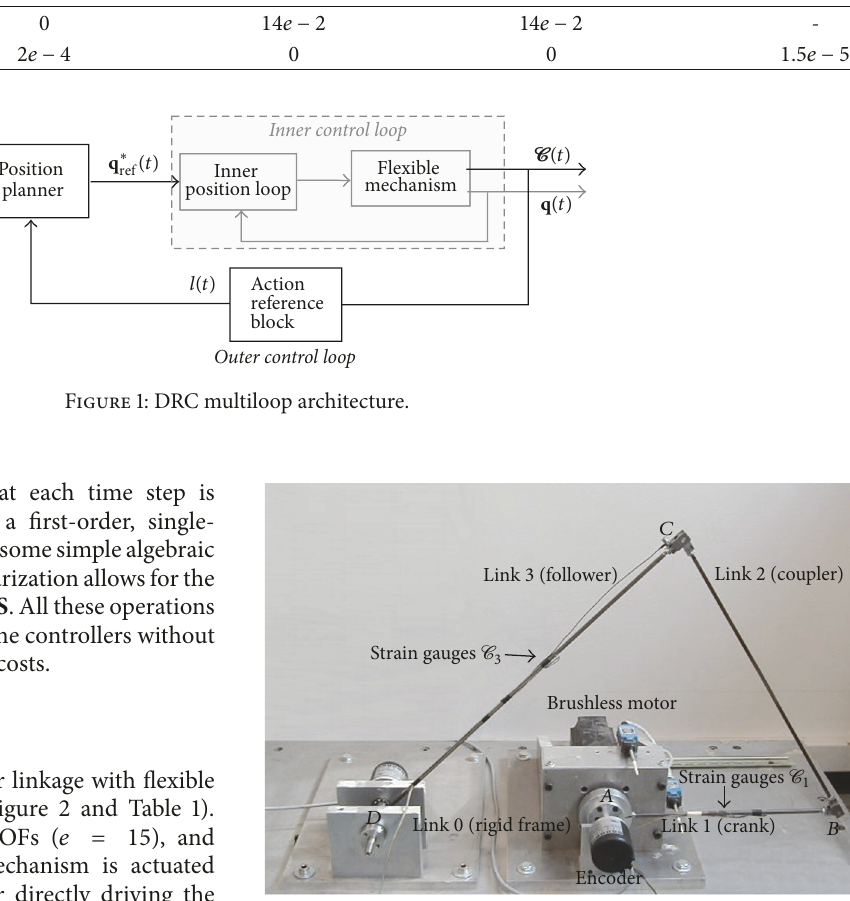
Figure 2: Picture of the